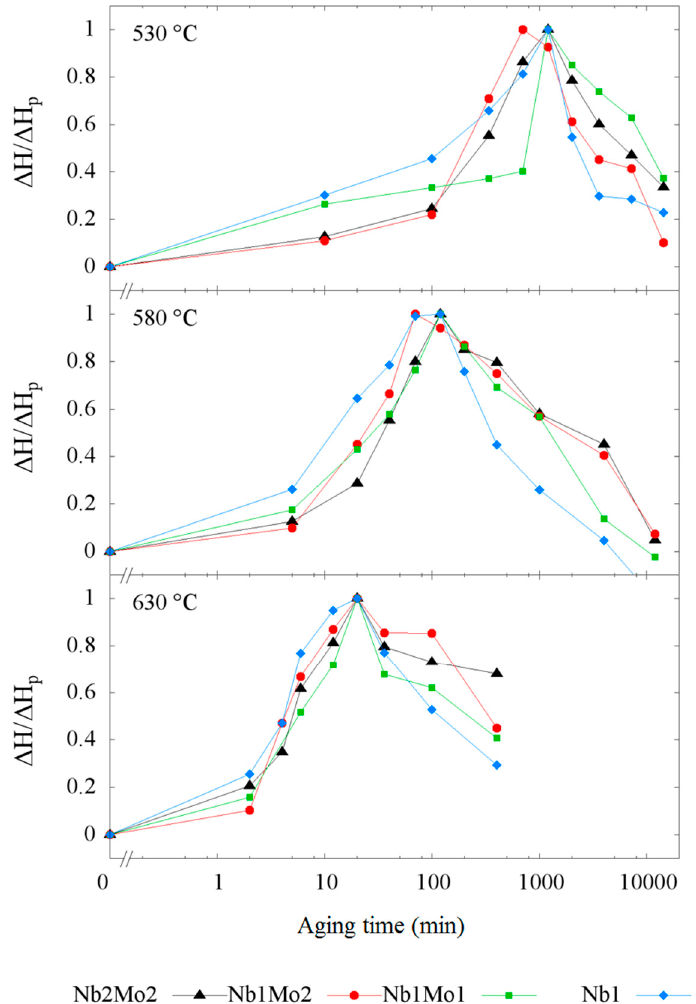
Figure 5. Comparison of the age hardening kinetics for the four Nb-bearing steels at the three aging temperatures of 530 °C, 580 °C and 630 °C.